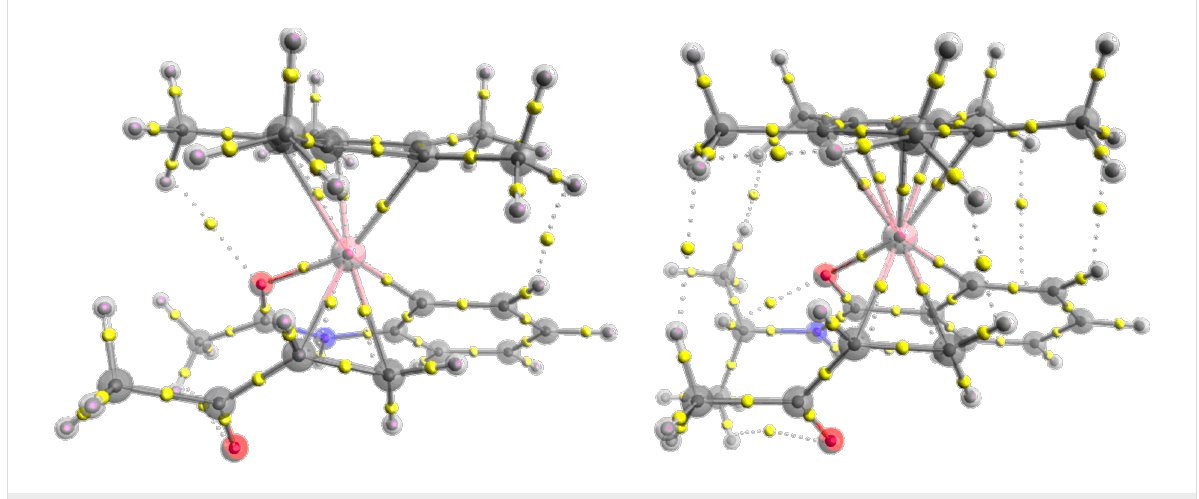
Figure 3: Comparative visualisation of bcp for Int 2 ketone with the acetanilide (left) and benzamide substrates (right).